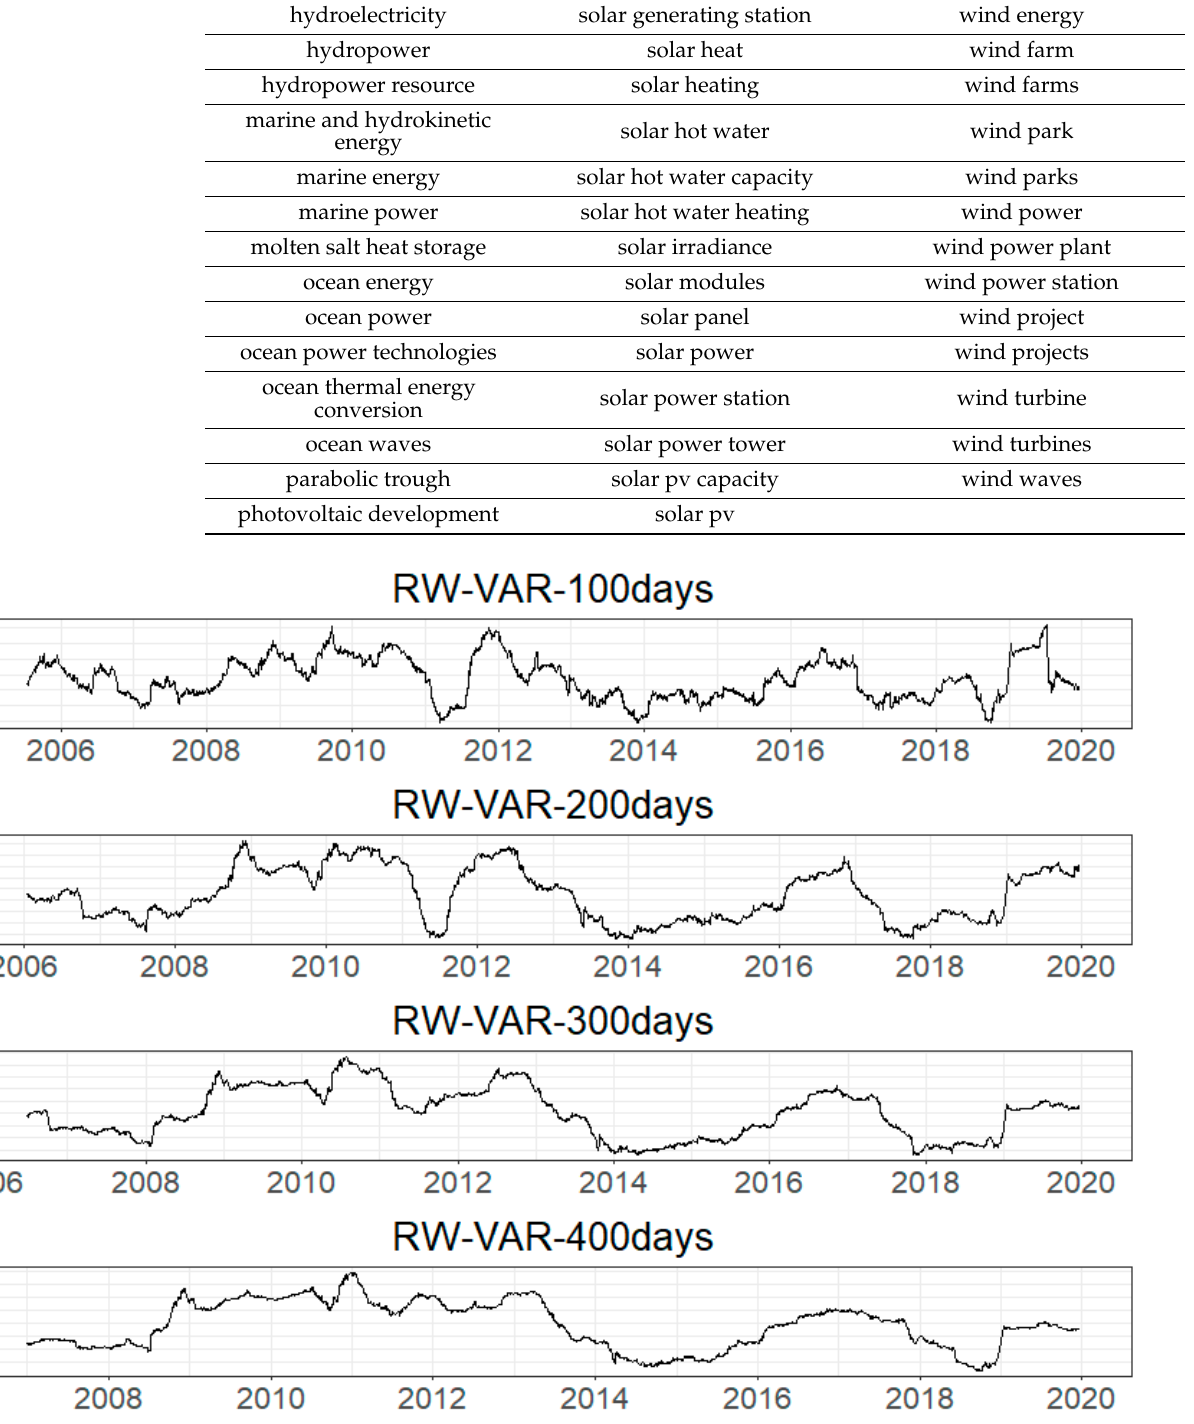
Figure A1. Dynamic total return connectedness via VAR-based connectedness approach with 100, 200, 300, and 400 days.